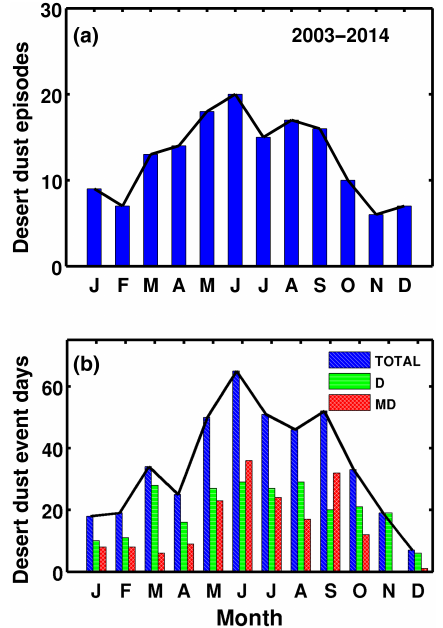
Figure 2. Annual cycle of (a) total number of episodes per month for total DD intrusions; (b) total (blue bars) number of days per month for total DD intrusions and for desert (D, green bars) and mixed desert (MD, red bars) categories in 2003–2014. Mean values per month can be derived by dividing by